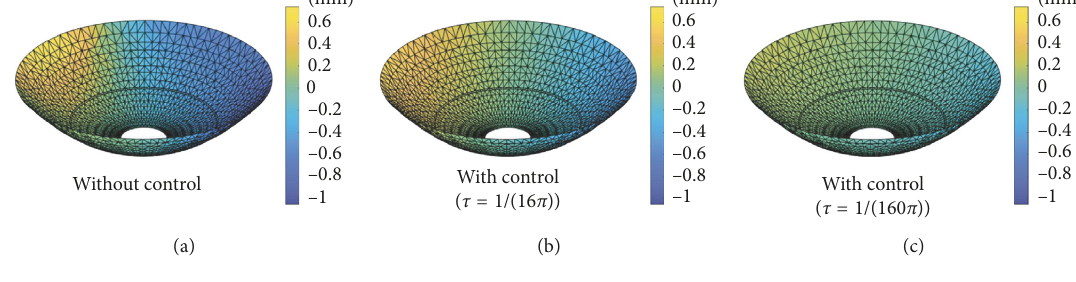
Figure 13: SVD in W direction at 3s.